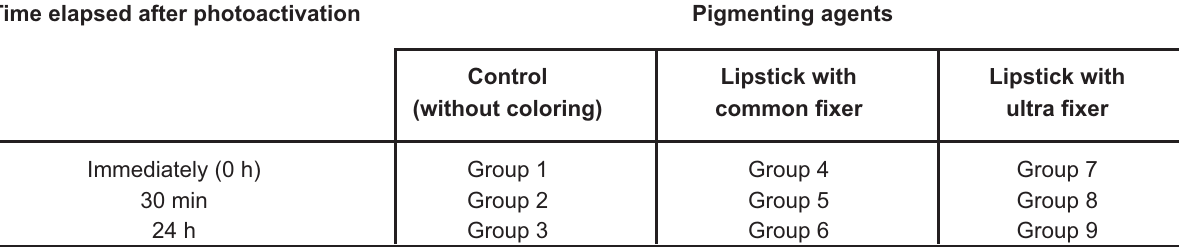
Figure 1- Study groups divided according to time elapsed between photoactivation and contact with lipstick, and